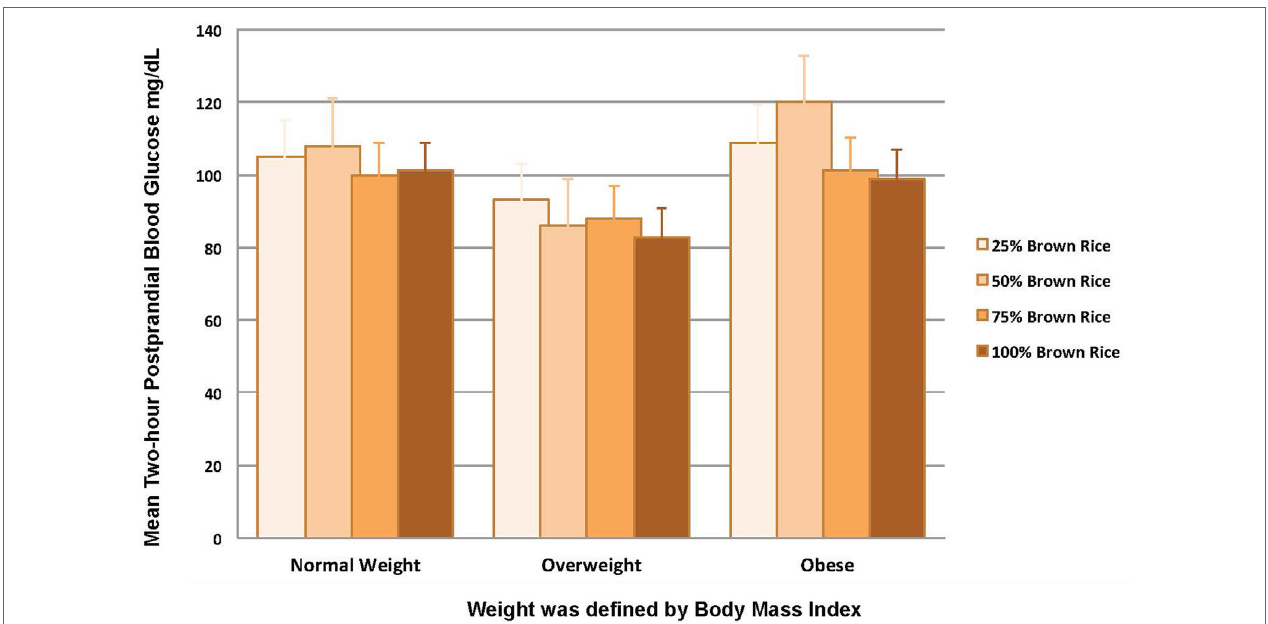
FigUre 3 | Two-hour postprandial blood glucose levels for each rice